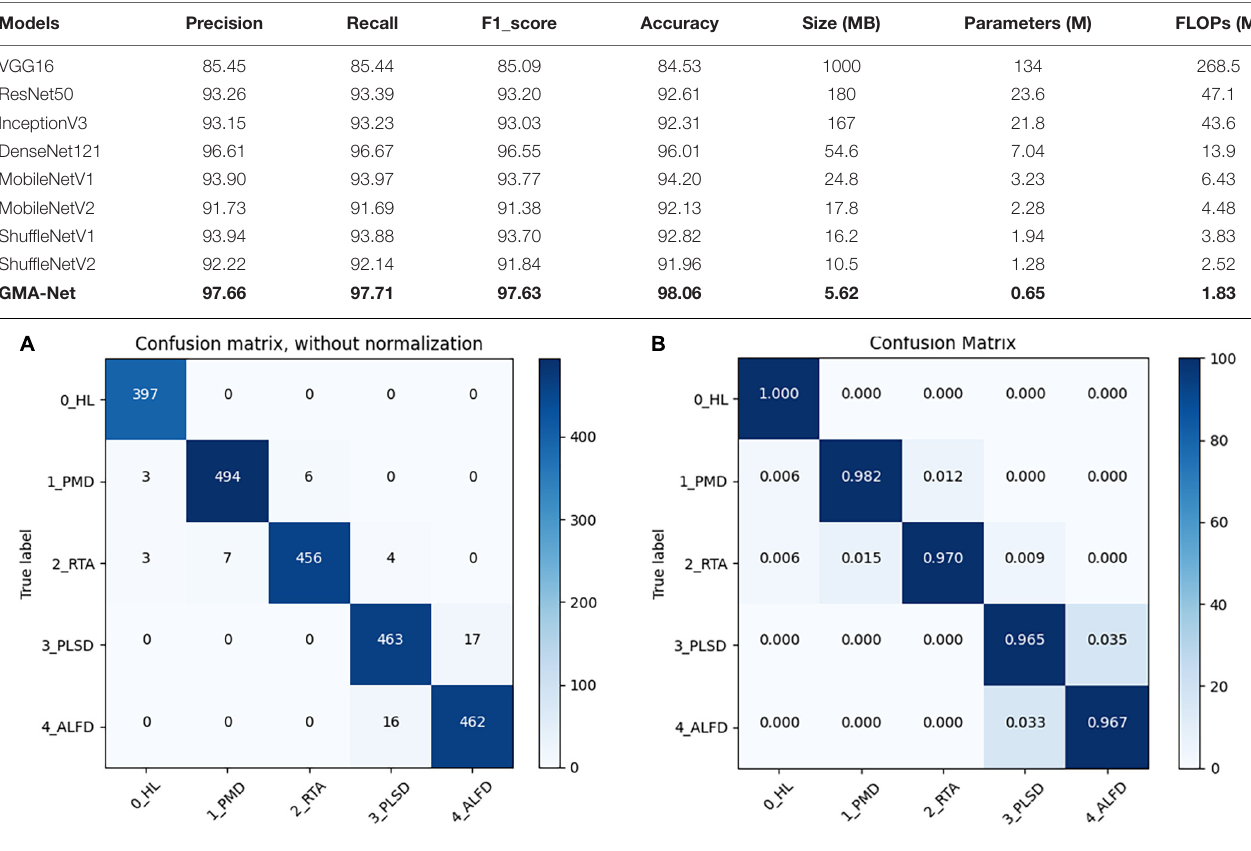
FIGURE 6 | Confusion matrix of GMA-Net. (A) Without normalization. (B) Normalized (“Healthy Leaves”: 0, “Powdery Mildew Disease”: 1, “Rubber Tree Anthracnose”: 2, “Periconla Leaf Spot Disease”: 3, “Abnormal Leaf Fall Disease”: